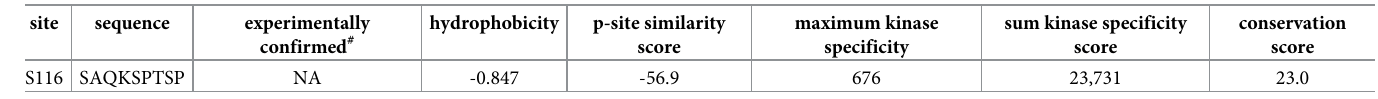
Table 6. Analysis of CPTAC-identified phosphorylation sites of SMARCA1 via the PhosphoNET database. site